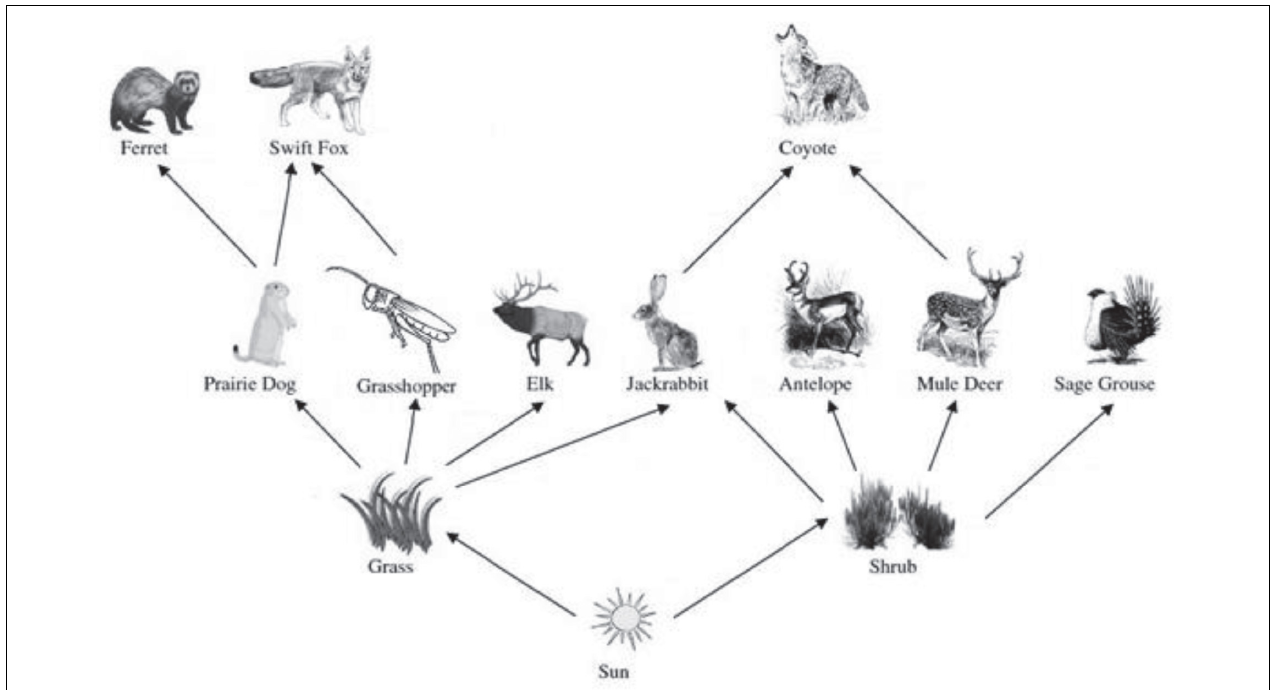
FIGURE 1 | Food web. Food web of 12 native species of a typical sagebrush ecosystem in Southern Wyoming. Grass and shrubs are the two plants. Grass-eating herbivores are elk, prairie dog, and grasshopper. Jackrabbits are both grass- and shrub-eaters. The arrows in the food web show the direction in which biomass and energy flow. The shrub-eating herbivores are antelope, mule deer, and sage grouse. The carnivores are ferret, swift fox, and